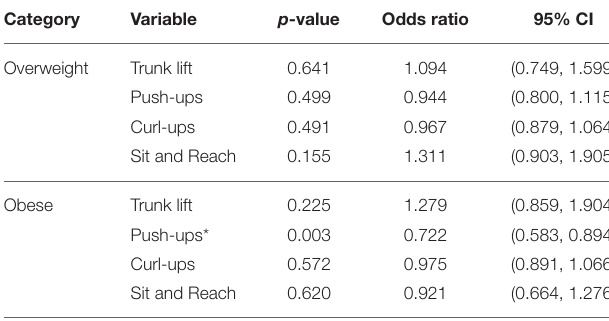
TABLE 7A | Associations between musculoskeletal fitness and weight status in fifth grade (reference group: healthy weight).